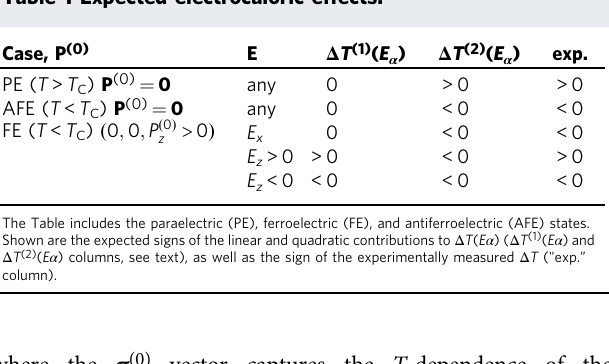
Table 1 Expected electrocaloric effects.